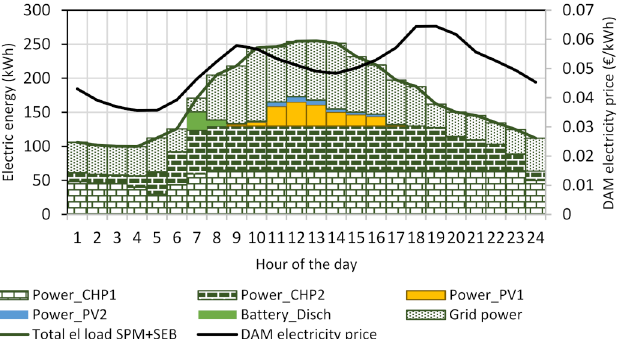
Figure 23. Electrical energy balance of the ILEC obtained with stochastic environmental optimization for the representative winter